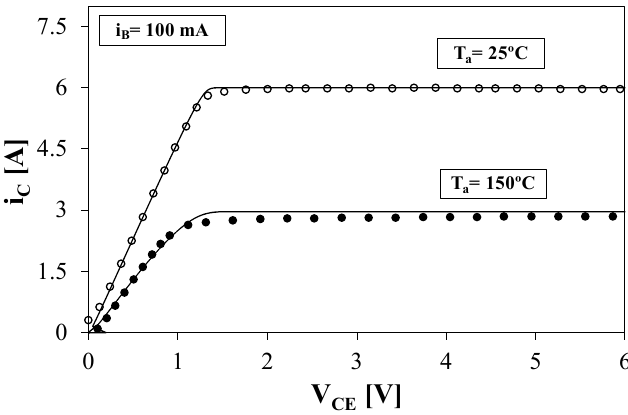
Figure 4. Isothermal output characteristics of the BT1206-AC transistor.